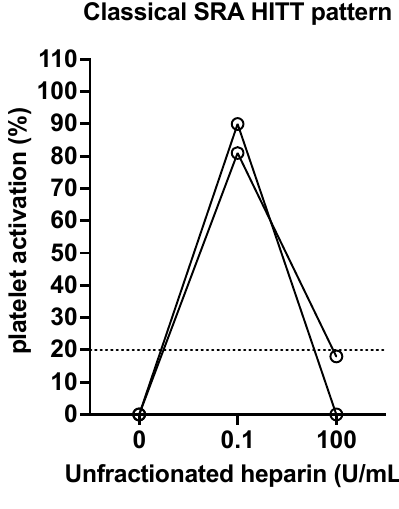
Figure 3. Two examples of a classical pattern expected for HITT positive cases assessed by SRA. In the absence of added heparin, no platelet activation should occur. In the presence of added heparin at a therapeutic level (0.1 U/mL final concentration in these examples), platelet activation, measured as serotonin release, occurs. In the presence of added heparin at a supra-therapeutic level (100 U/mL final concentration in these examples), platelet activation, measured as serotonin release, is inhibited (i.e., no release occurs). Occasionally, platelet activation may also occur in the absence of added therapeutic heparin level, due to the presence of either strong antibodies or heparin in the patient’s plasma. Occasionally, again due to the presence of strong antibodies, platelet activation may not fully normalize in the presence of an administered supratherapeutic heparin level.